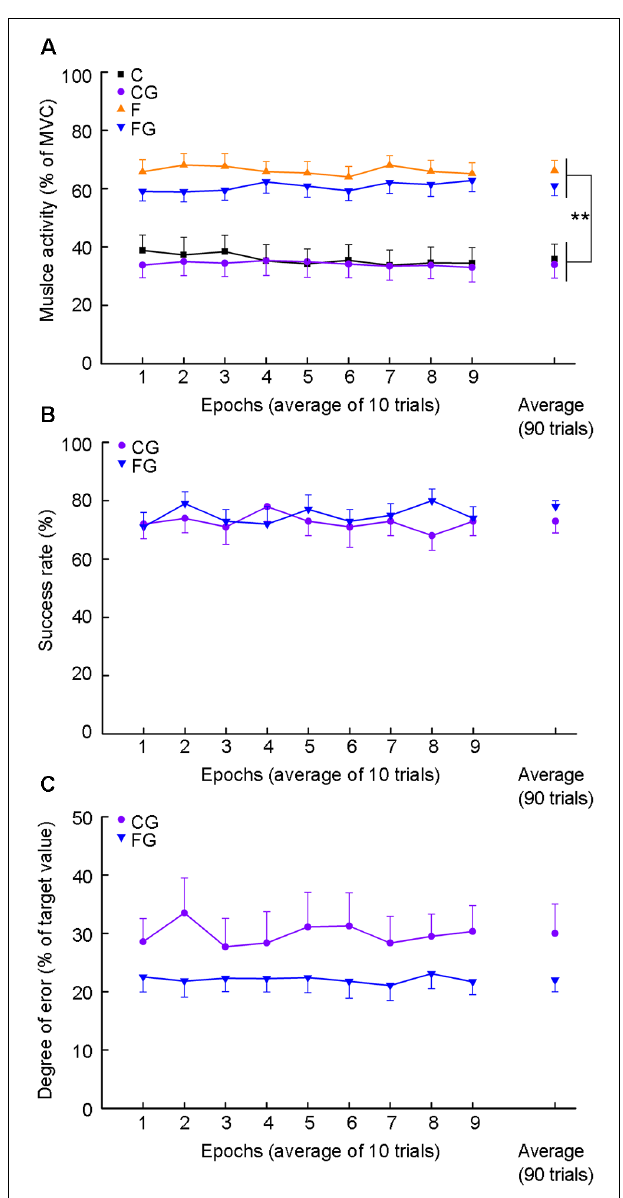
FIGURE 2 | Muscle activity, success rate, and degree of error for motor tasks. Data obtained from 15 subjects. (A) Average muscle activity for four motor tasks. The abscissa indicates nine epochs by binning 10 consecutive movements and average muscle activity (right plots). The ordinate indicates muscle activity expressed as average peak EMG activity normalized as a percentage of maximum voluntary contraction (MVC). (B) The success rate for two controlling tasks. The ordinate indicates the success rate. (C) Degree of error for two controlling tasks. The ordinate indicates the degree of error. The degree of error was calculated as the absolute vertical distance from the peak EMG activity of each trial to the target center, and normalized as a percentage of the values of the target center, i.e., mean of the C in the CG and mean of the F in the FG. ** P < 0.01, comfortable muscle activity vs. forceful muscle